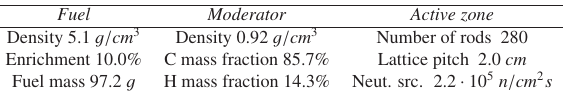
located within the assembly core: EC1 (core center), EC2 (core middle part) and EC3 (core periphery). The Yalina- Thermal 3D-view blueprint is shown on figure 1. The main parameters are presented in table 1. Table 1: Yalina-Thermal assembly main design character- istics